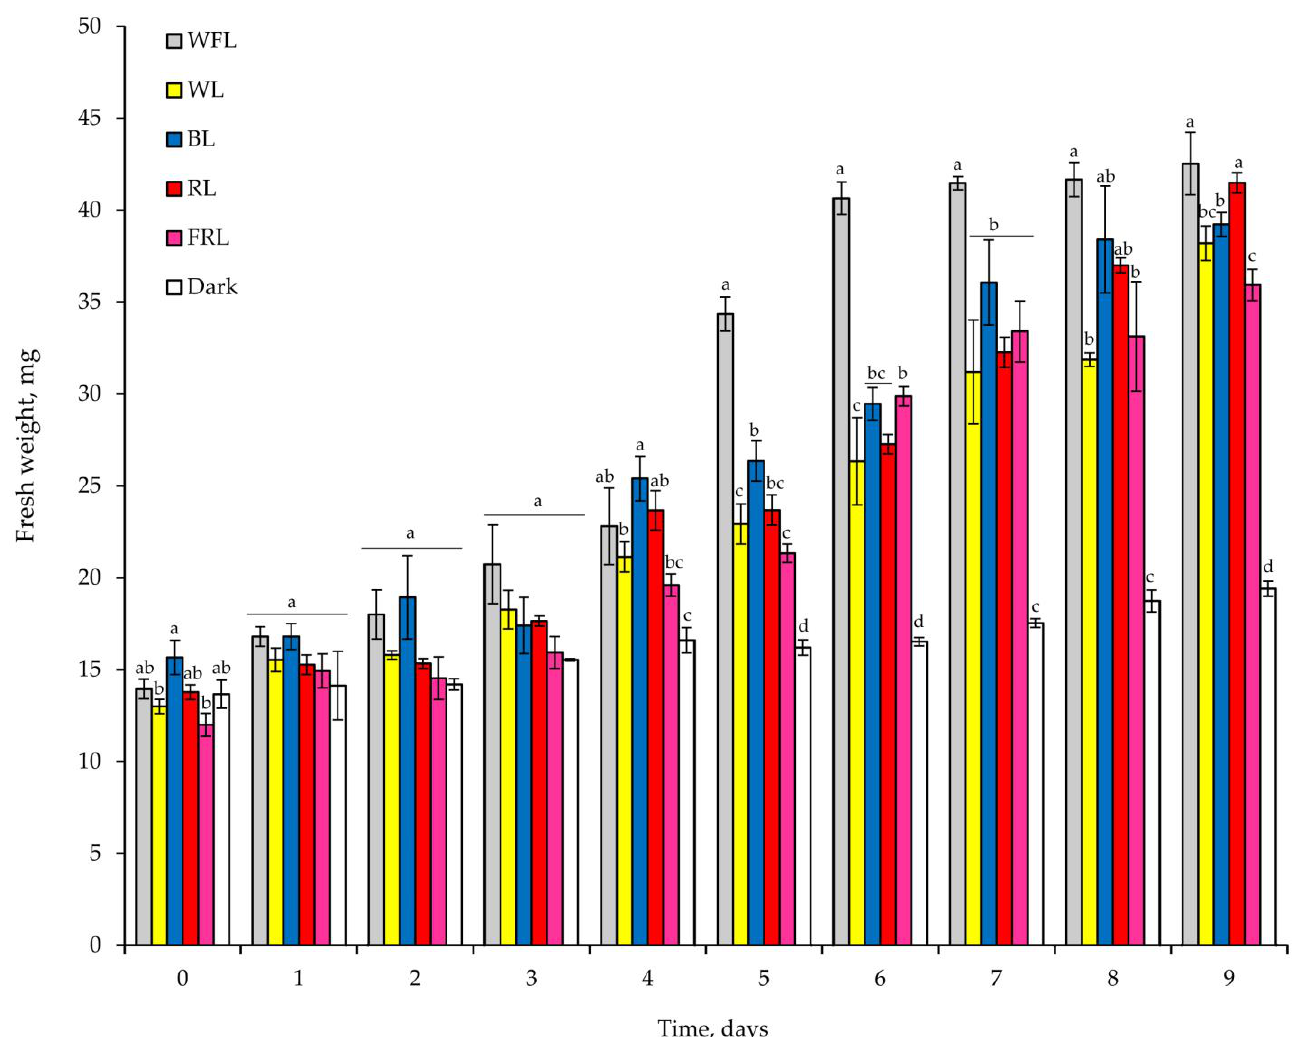
Figure 1. Effect of light quality on the fresh weight of Scots pine plantlets with seed coats during the experiment. Different letters denote statistically significant differences in the means at p < 0.05 (one-way ANOVA followed by Duncan’s post hoc test) between the experimental treatments within each day of observation, n = 3 – 6.